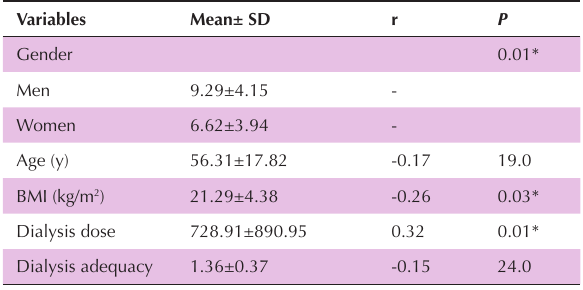
Table 1. Correlations of various demographic data with serum irisin Variables